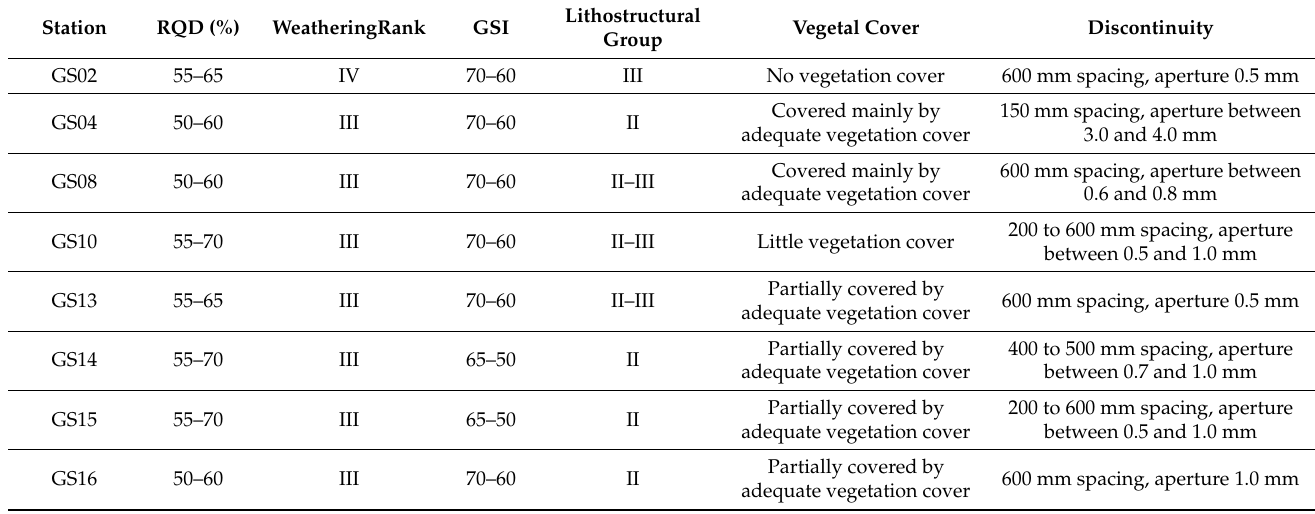
values are in categories II and III. Table 13. Geomechanical characteristics of the rock